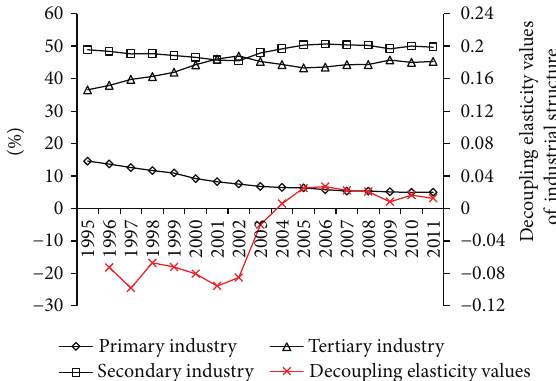
Figure 4: Industrial structure and decoupling elasticity values of industrial structure from 1995 to